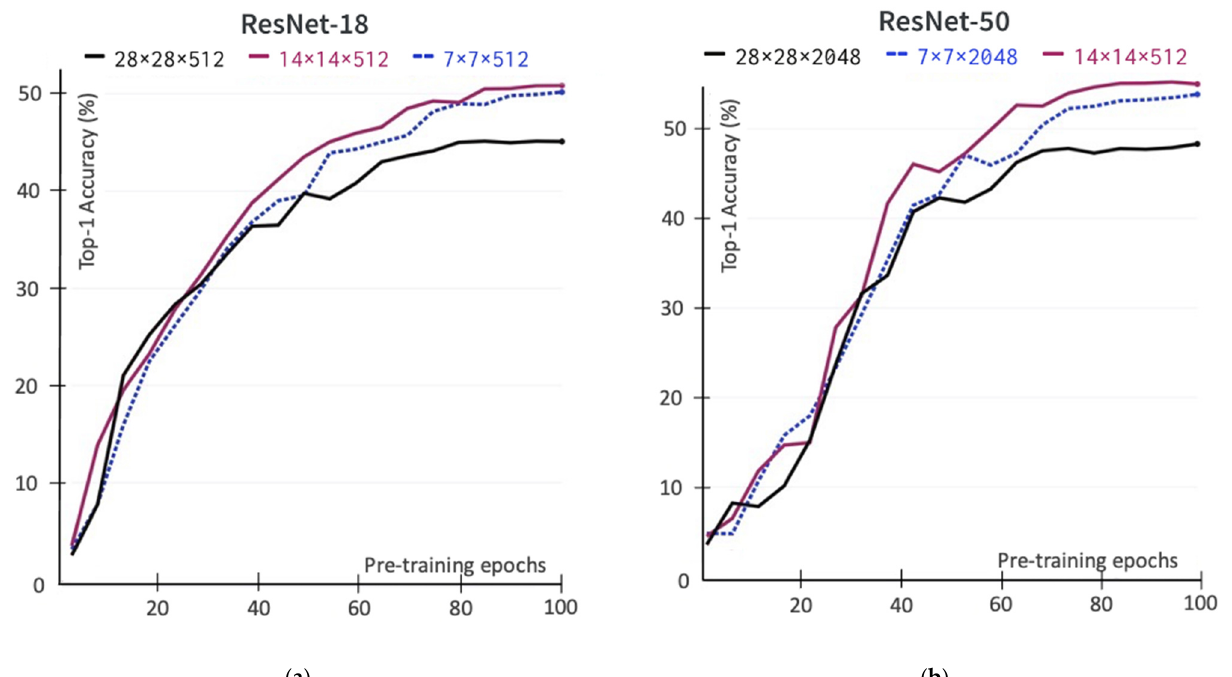
Figure 3. The ImageNet linear evaluation Top-1 accuracy (in %) of spatial output feature maps in various sizes and dimensions during the self-supervised pretraining stage. ( a ) The self-supervised pre-trained encoder uses the ResNet-18 backbone; ( b ) The self-supervised pre-trained encoder uses the ResNet-50 backbone.